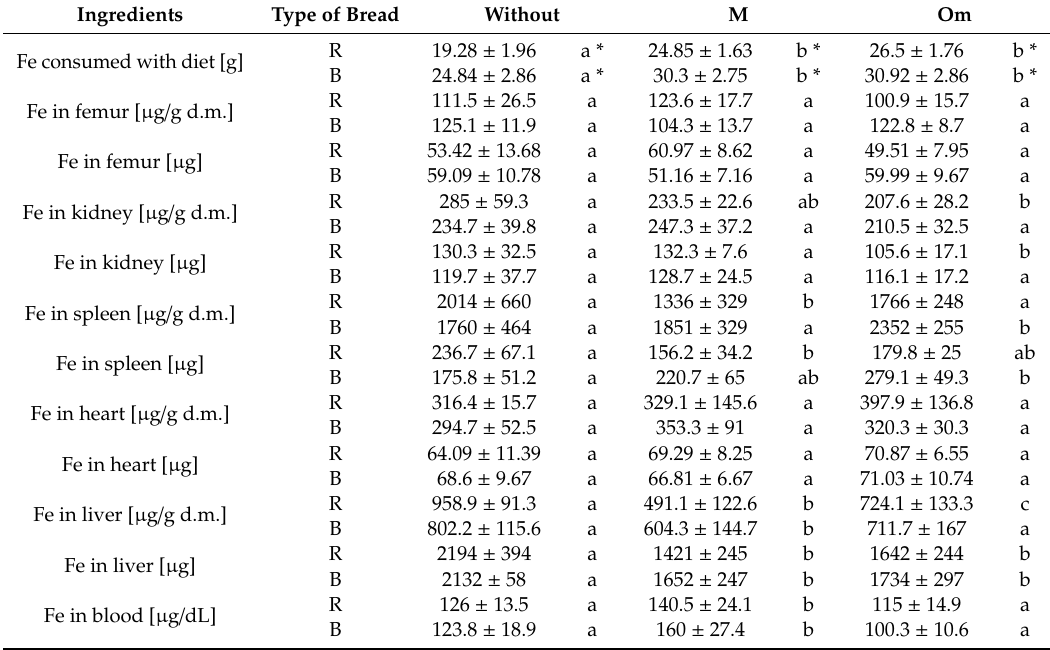
Table 3. Iron content in organs.